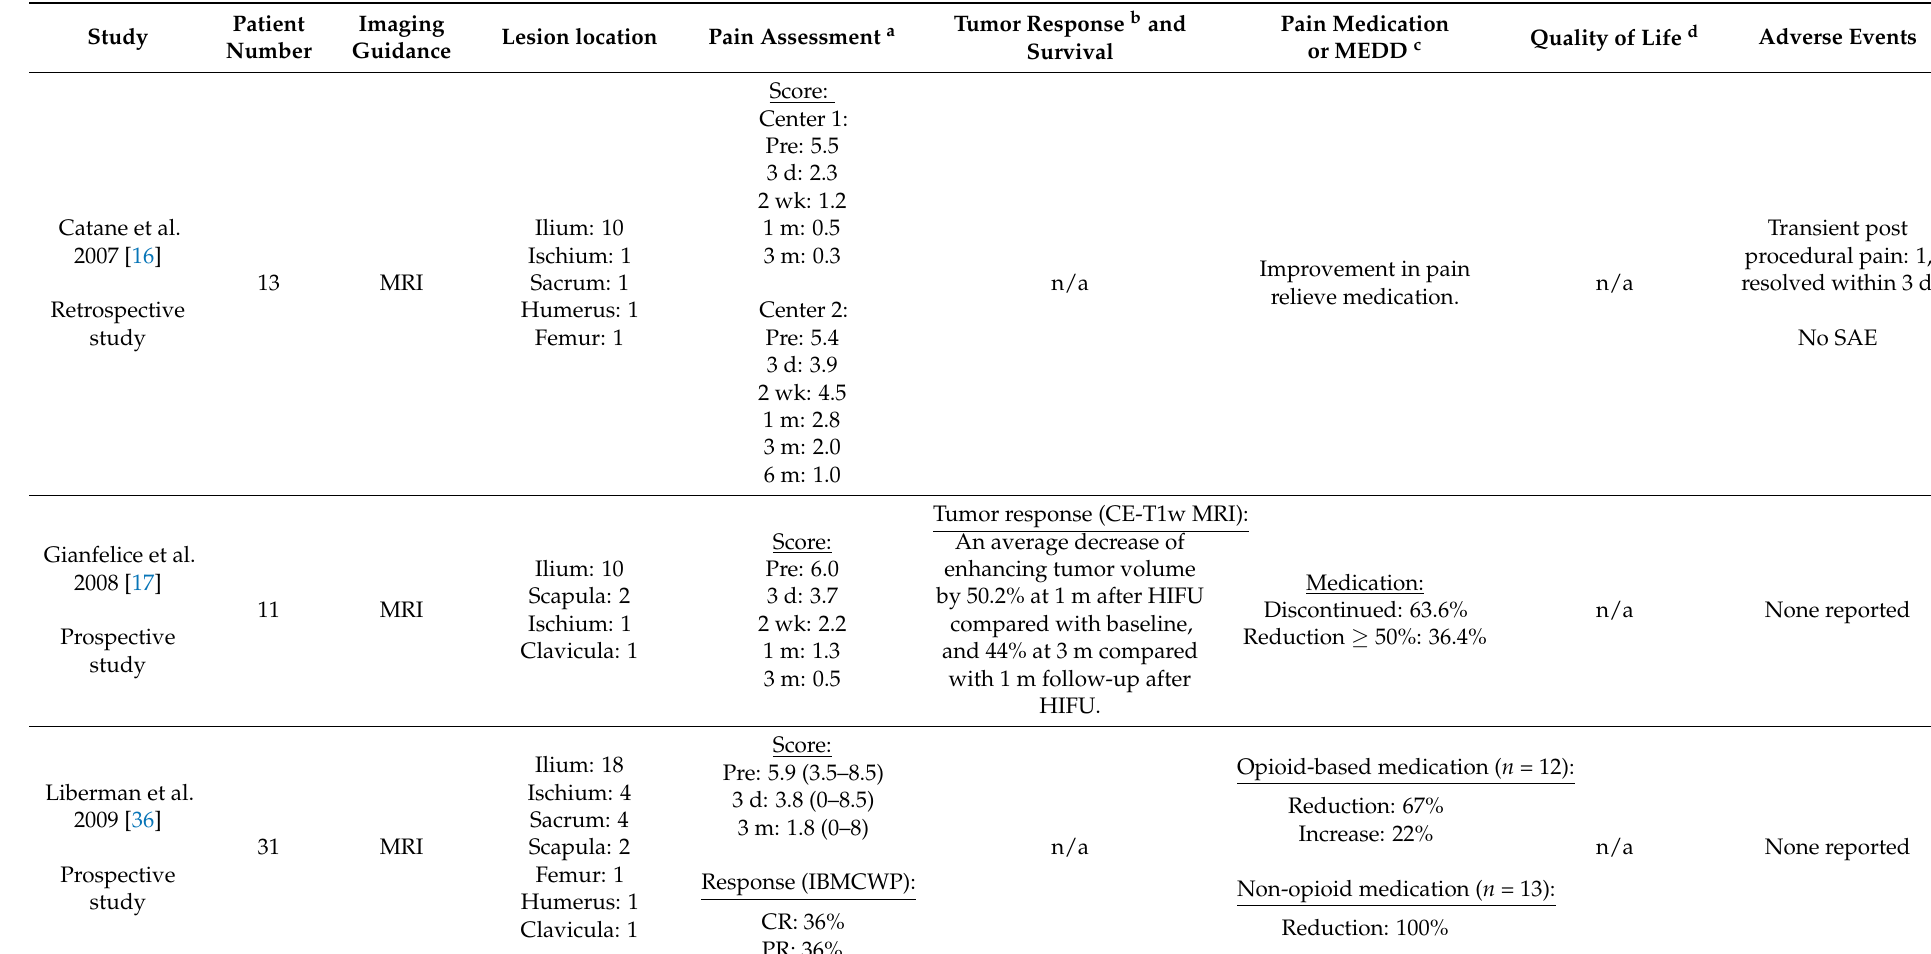
Table 1. A summary of clinical studies on HIFU treatment of bone